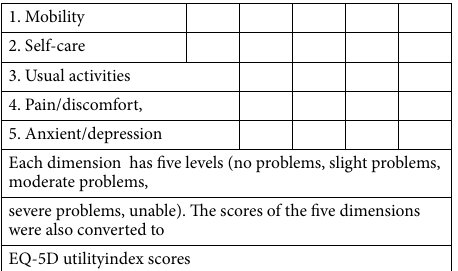
Table 2. Five dimensions of Health Questionnaire English version (EQ-5D-5L).